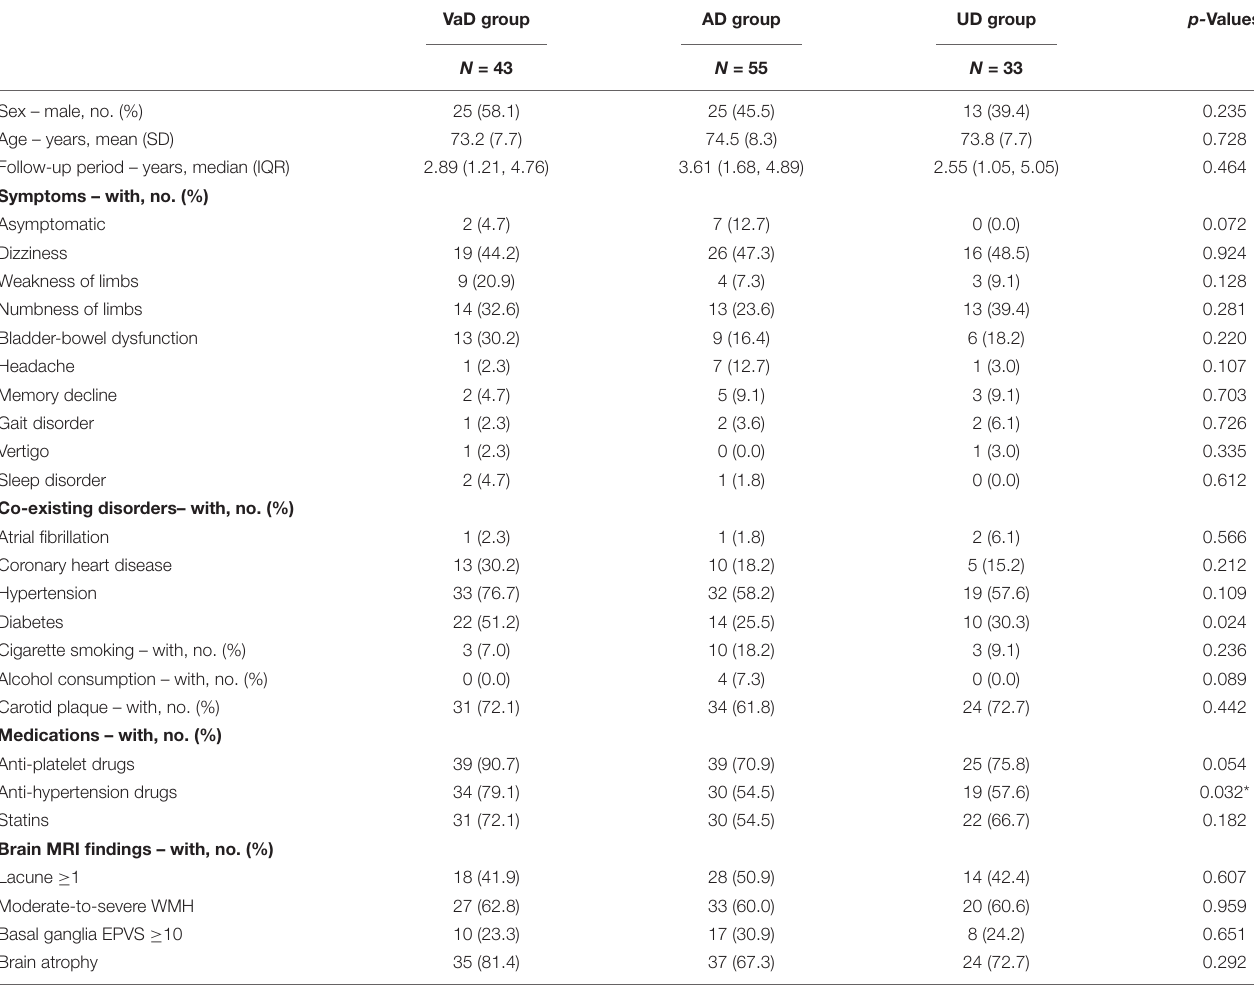
TABLE 2 | The baseline characteristics of 131 cases grouped by specific dementia. VaD group AD group UD group p- Values N =